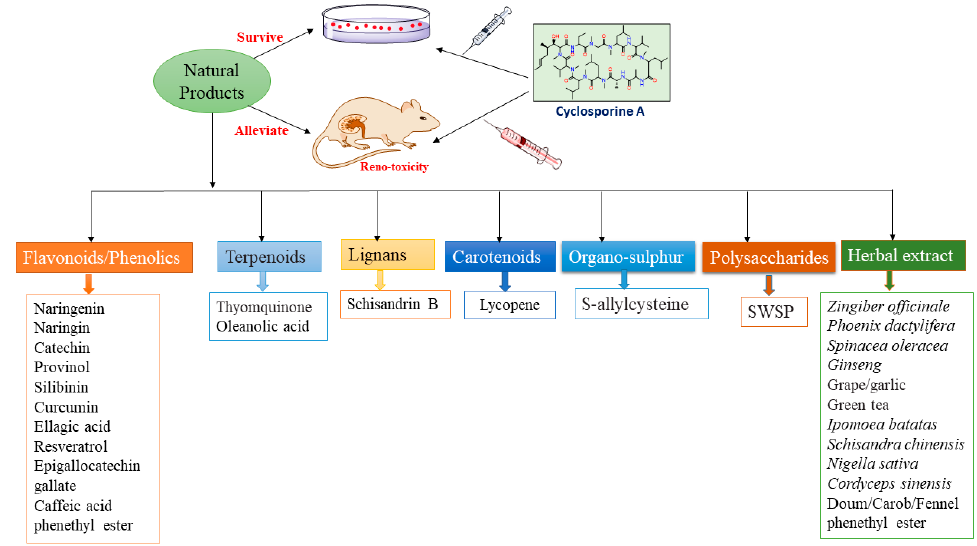
Figure 4. Different classes of natural products protect against CA-induced nephrotoxicity.